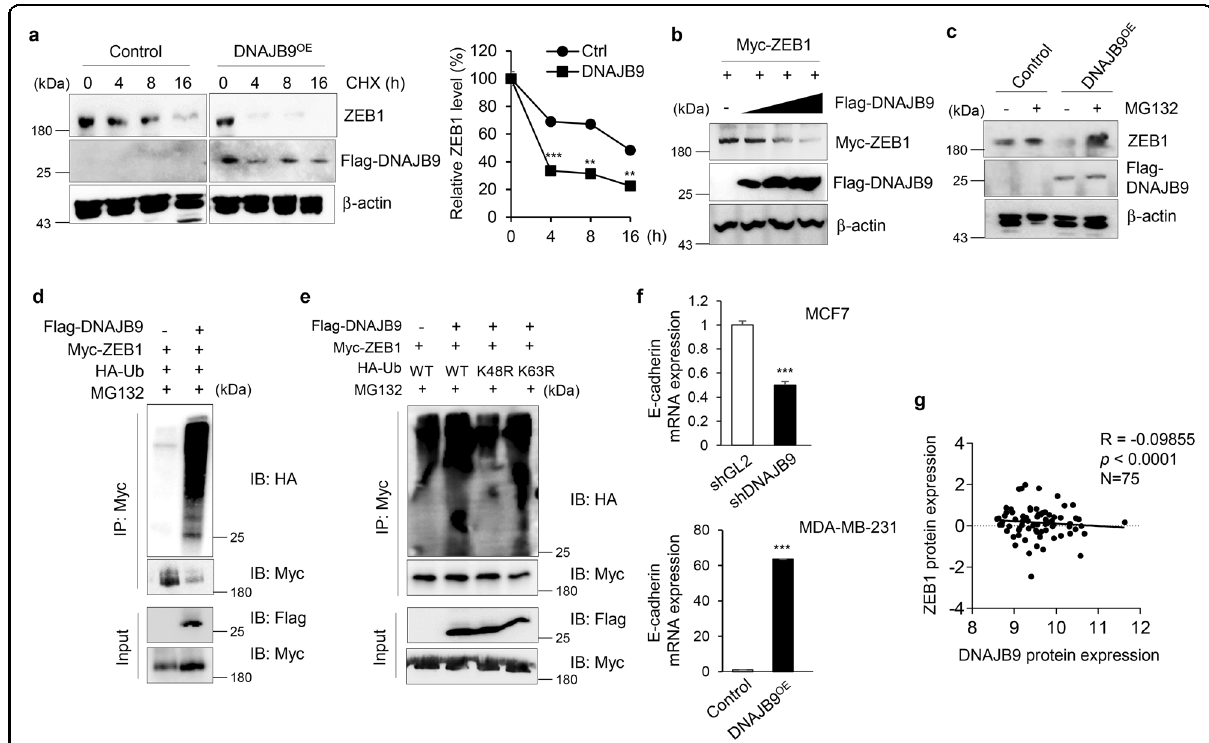
Fig. 3 DNAJB9 promotes ZEB1 degradation via a proteasomal pathway. a Western blotting. Stability of ZEB1 was detected using western blotting of MDA-MB-231 – DNAJB9-OE or control cells in 10 μ M cycloheximide for the indicated times (left panel). The band intensity of ZEB1 at each time point was normalized compared with that of β -actin and converted into percentages using 100% as the value of zero time point (right panel). b To determine the inhibitory effect of DNAJB9 on ZEB1, increasing amounts of DNAJB9 constructs were transfected into HEK293 cells. The level of ZEB1 was detected using western blotting. c To check the proteasome-mediated degradation of ZEB1 by DNAJB9, MDA-MB-231 cells were incubated with MG132 (10 μ M) for 16 h, and the level of ZEB1 was examined using western blotting. d HEK293T cells were transiently co-transfected with the control vector, Flag-DNAJB9, and with Myc-ZEB1 or HA-ubiquitin as indicated. At 36 h post-transfection, the cells were incubated with MG132 for 6 h and then subjected to ubiquitination assay. In all, 10% of cell lysates were used for the analysis of input. e To determine the DNAJB9-mediated ubiquitination type of ZEB1, DNAJB9 and ZEB1 constructs were transfected into HEK293T cells with various ubiquitin plasmids. Ubiquitinated ZEB1 was detected with anti-HA antibody from immunoprecipitated ZEB1 protein. f The expression level of E-cadherin gene was detected using qRT – PCR in DNAJB9-modulated MCF7 and MDA-MB-231 cells. Cyclophilin was used as normalization controls. g The Pearson correlation between DNAJB9 and ZEB1 protein expression in 75 breast cancer tissues from The Cancer Genome Atlas database. The Pearson correlation coef fi cient ( R ) and p value ( p ) are reported. Results are presented as the mean ± standard deviation from three independent experiments. ** p < 0.01; *** p <